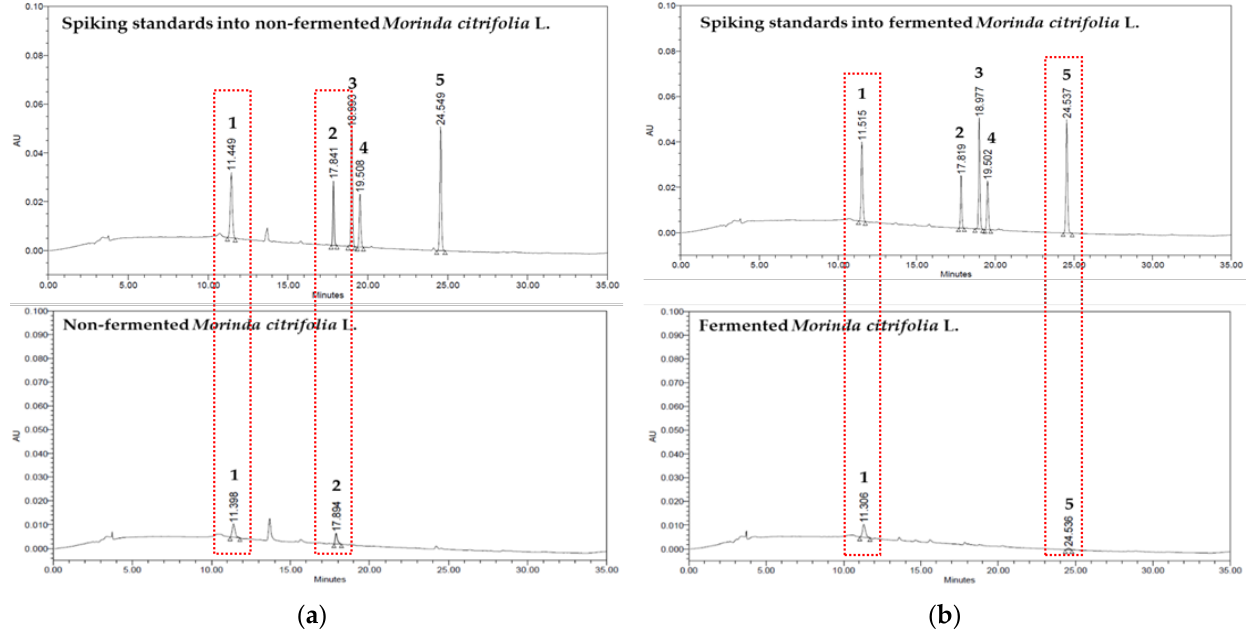
Figure 2. HPLC chromatographic of bioactive compounds marked with 1–5 represent deacetylasperulosidic acid, asperulosidic acid, scopolin, asperuloside and scopoletin spiked non-fermented ( a ) and fermented ( b ) Morinda citrifolia L. extracts. Table 1. Coefficient of determination of the calibration curves, LOD and LOQ of bioactive compounds analysis for non-fermented and fermented Morinda citrifolia L.